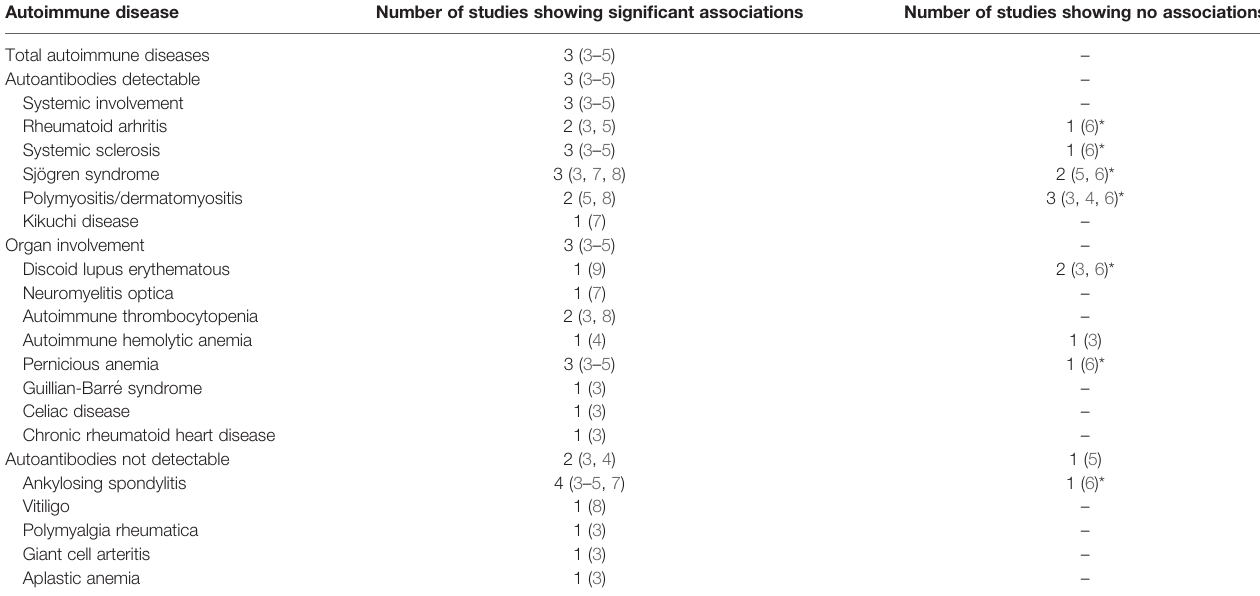
TABLE 1 | Autoimmune diseases associated with